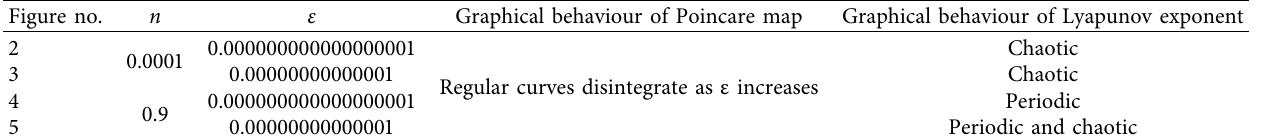
1: Earth-Resourcesat-1 system for fixed values Figure no. Graphical behaviour of Poincare map